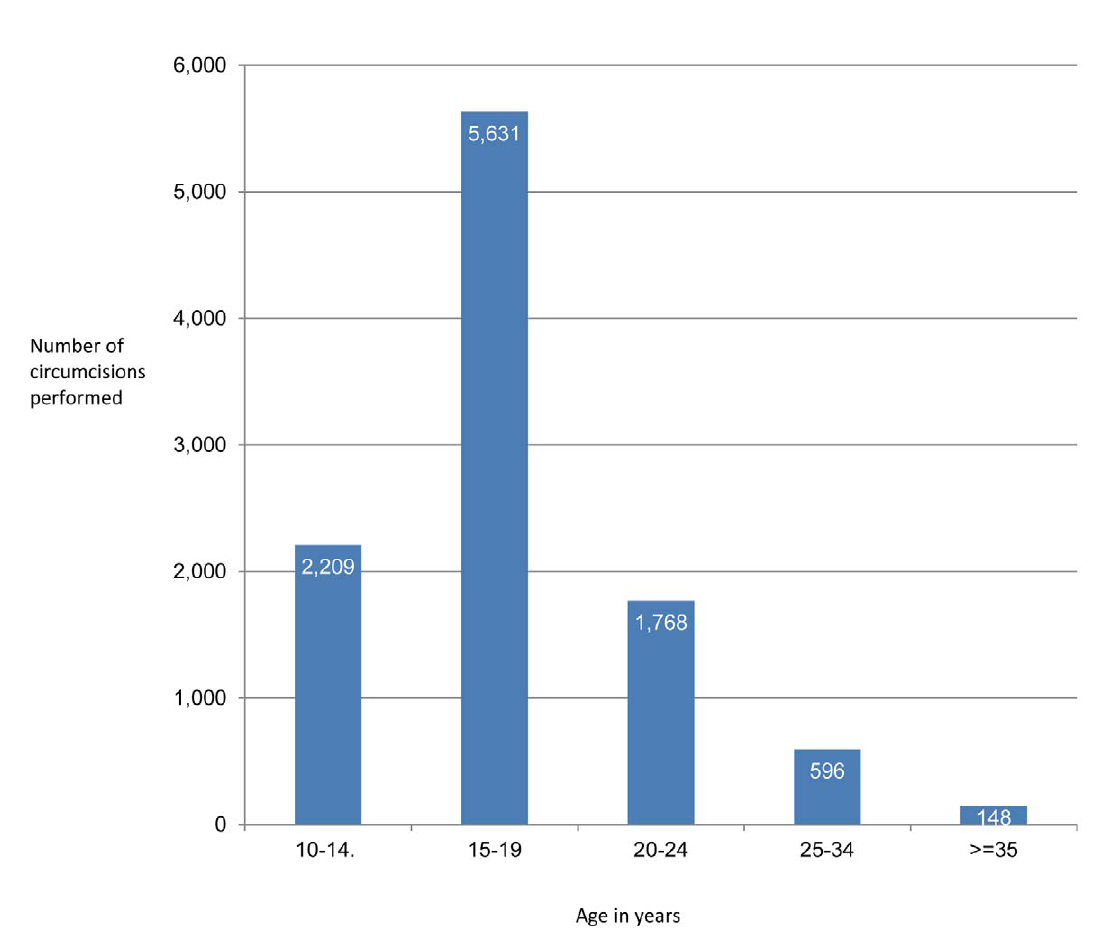
Figure 4. Age distribution of VMMC clients.